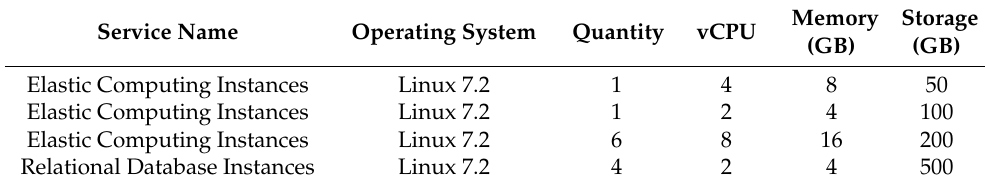
Table 8. Cloud resource list for Pattern II.